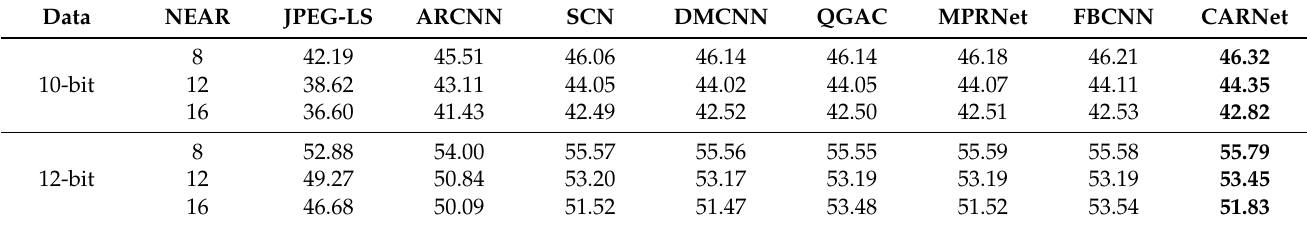
Table 4. LS-PSNR (dB) results, data type: 10-bit (NEAR = 8) means a 10-bit remote sensing image compressed by JPEG-LS with a NEAR value set to 8. Best results bold.